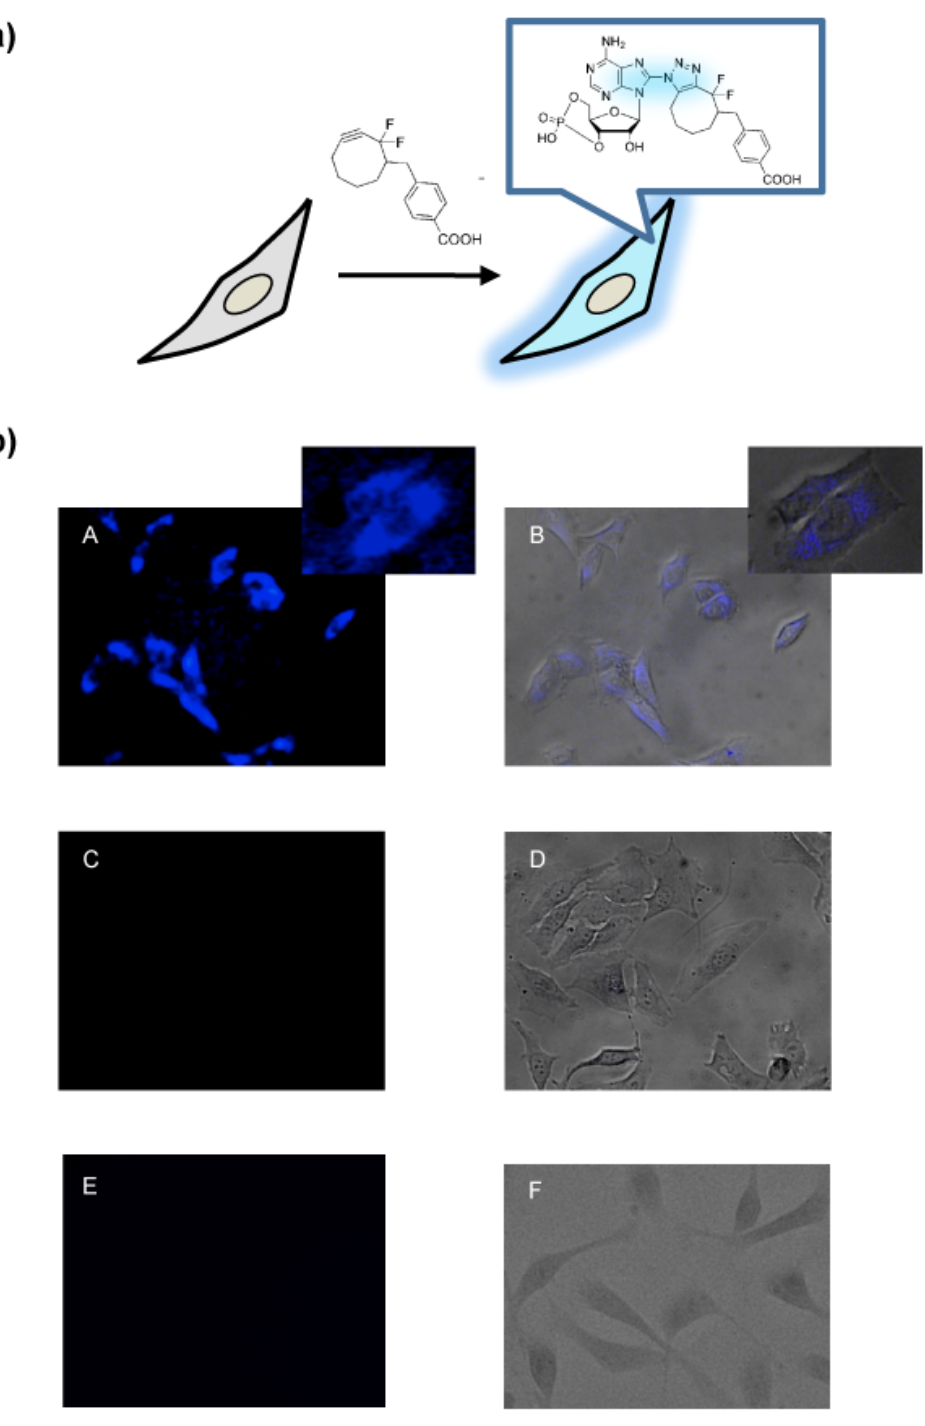
Figure 2. Direct detection of cAMP in living cells. ( a ) Schematic for detection of cAMP in living cells using the DIFO reagent. The azide-alkyne cycloaddition product in living cells emits fluorescence. ( b ) Fluorescence microscopy images of live cells. (A, B) Hela cells with 8-azido cAMP were incubated with the DIFO reagent. Small panels show the enlarged image. (C, D) Hela cells without 8-azido cAMP as a negative control. (E, F) Hela cells without the DIFO reagent as a negative control. B, D and F panels show fluorescence images merged with bright field